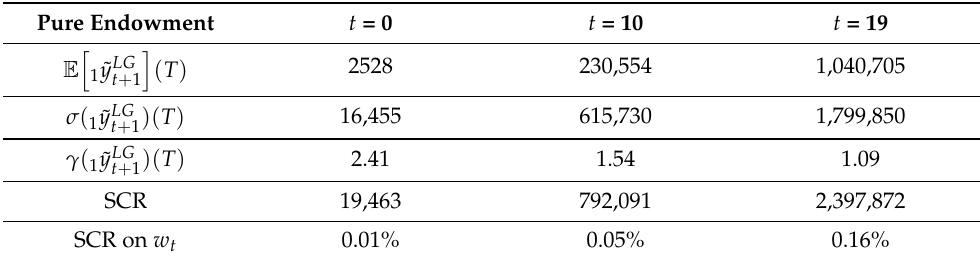
Table 5. Local GAAP results—Pure Endowment.